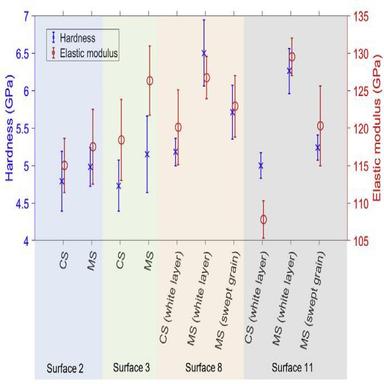
Hardness and elastic modulus results from nanoindentation measurements of machined surface (MS) and cross-section (CS) samples.